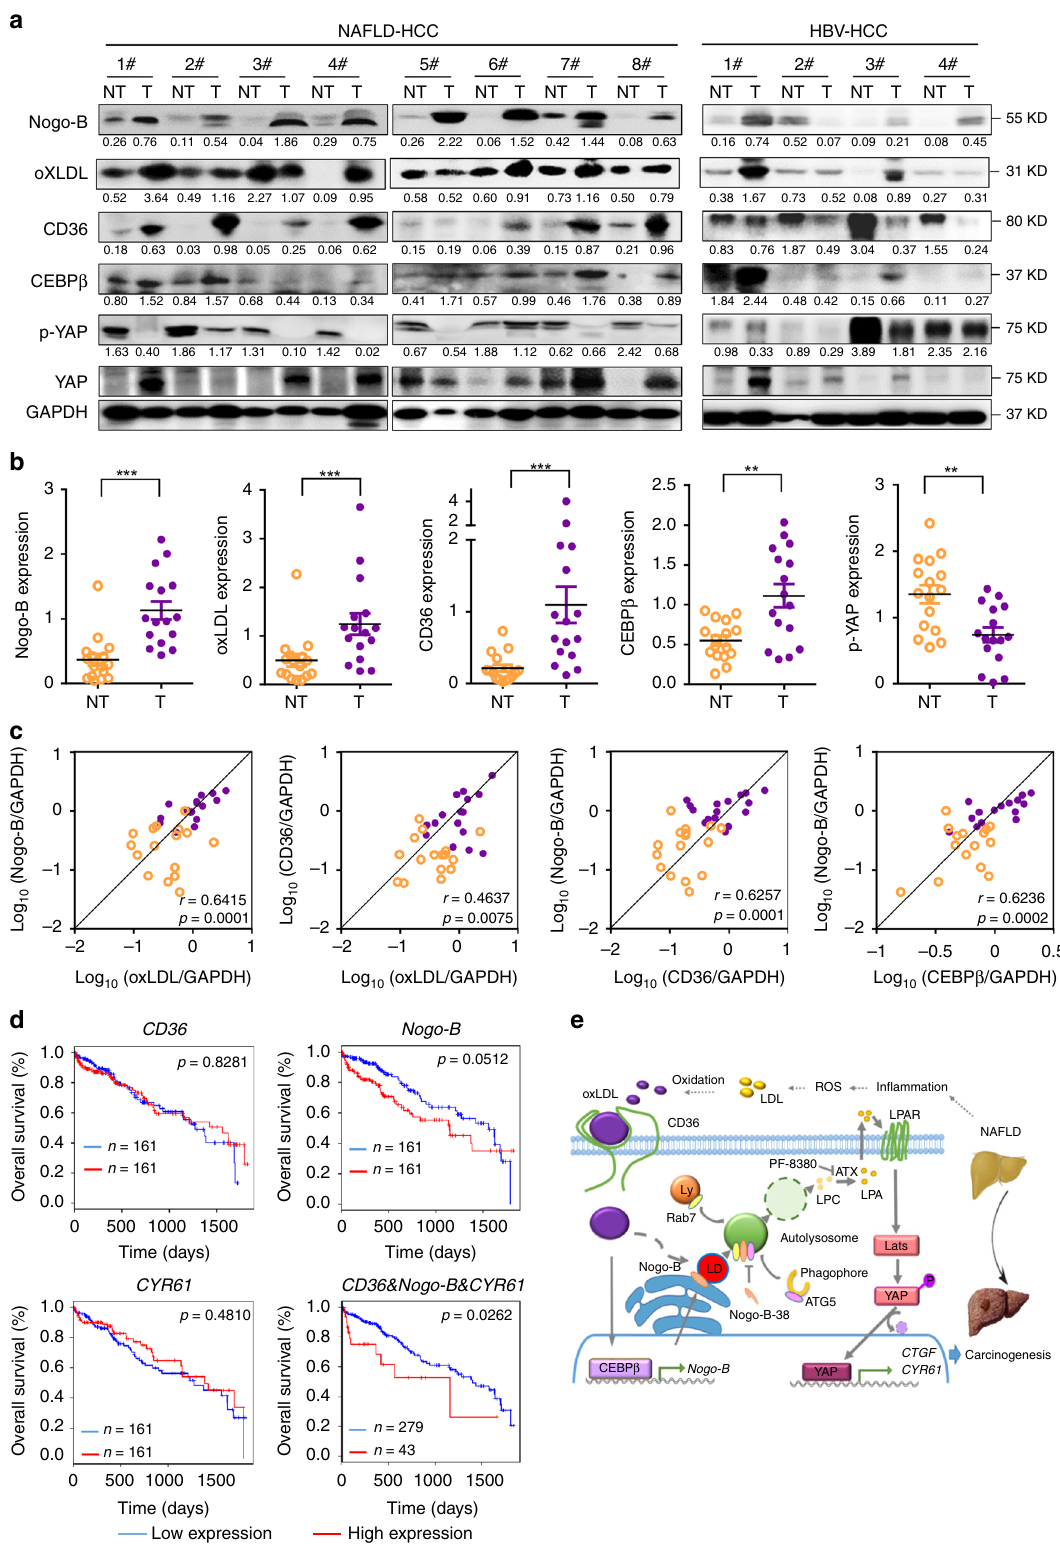
Fig. 7 Enhanced Nogo-B cascade in clinical NAFLD-associated HCCs. a Representative blots of western blot analysis of upregulation of Nogo-B, oxLDL, CD36, and CEBP β , and inhibition of YAP phosphorylation in eight paired human NAFLD-associated HCCs (left) and four paired human HBV-associated HCCs (right) (T, tumors; NT, adjacent normal tissues). b Quanti fi cation of Nogo-B, oxLDL, CD36, CEBP β , and p-YAP in 16 pairs of NAFLD-associated HCC patient samples. (* p <0.05; ** p < 0.01; *** p < 0.001. Source data are provided as a Source Data fi le). c Correlation analysis of protein levels of Nogo-B and oxLDL-CD36-CEBP β cascade in 16 pairs of NAFLD-associated HCC patient samples. d Kaplan – Meier analyses for HCC patients with tumors expressing high or low level of CD36, Nogo-B, or CYR61. e Working model of Nogo-B-promoted LD degradation and activation of YAP signaling in NAFLD-associated